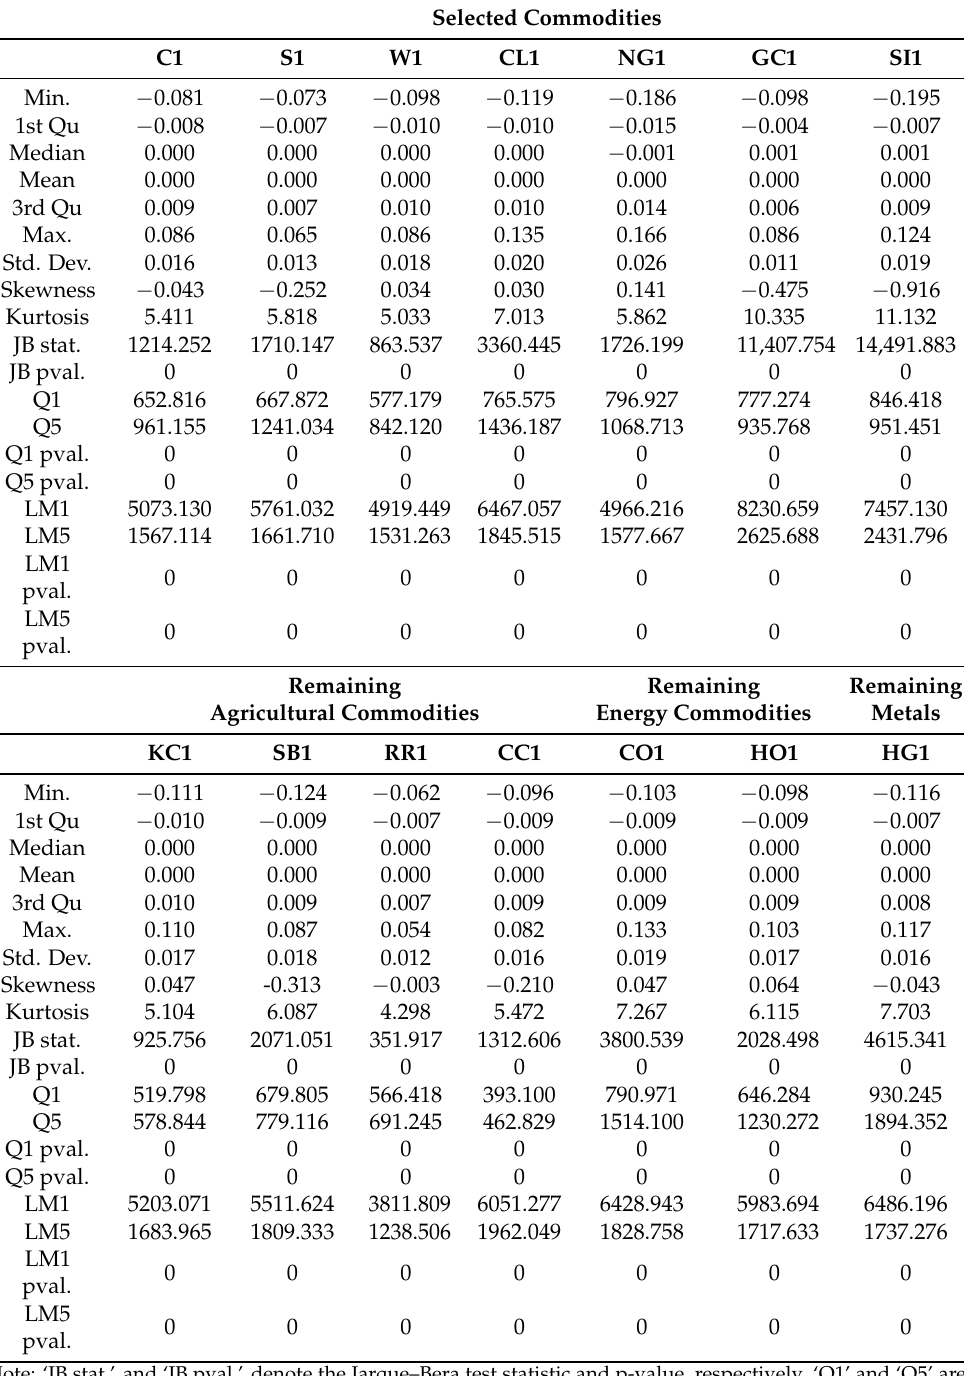
Table 2. Descriptive statistics for the log-returns of commodities